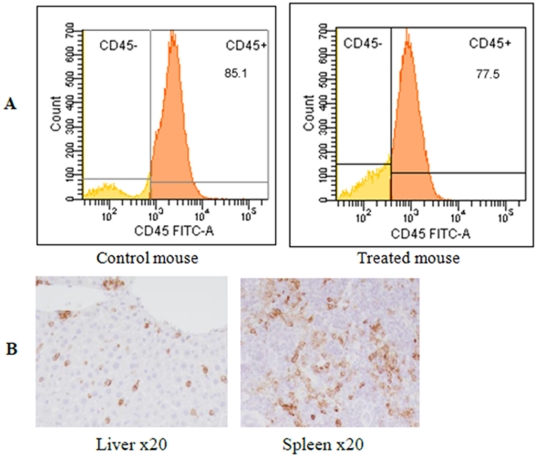
(A) Representative flow cytometric analysis of bone marrow of a mouse transplanted with leukemic cells from patient AML sample treated or not with anti-hCD45 mAb. The bone marrow is overrun by CD45+ cells in the two cases. (B) Liver and spleen CD45 immunostaining at x20.